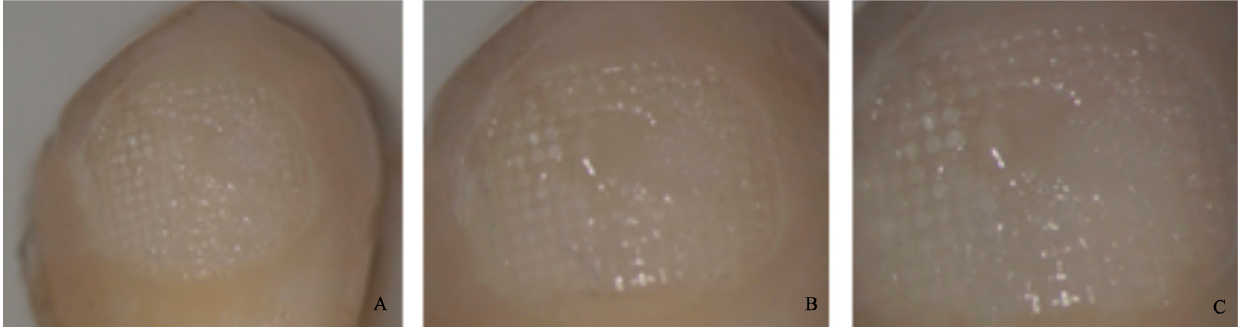
Figure 7. Score 3. ( A ) Magnification: 10 × 1; ( B ) Magnification: 10 × 1.6; ( C ) Magnification: 10 × 2.5.